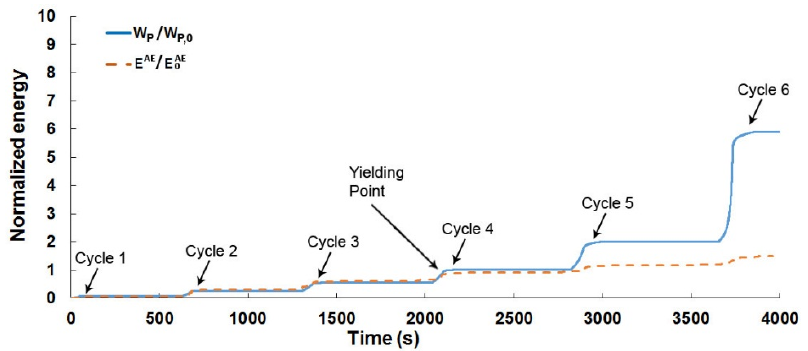
Figure 5 . Accumulated AE energy (dashed line) and accumulated hysteretic strain energy (solid line). RC beam without notch.